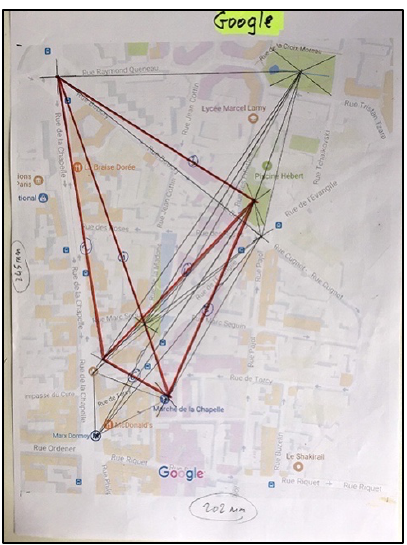
Figure 14. Measurement of distances between 6 landmarks in Google Map. Relative comparison between internal distances in geographical landmarks and internal distances between drawing landmarks